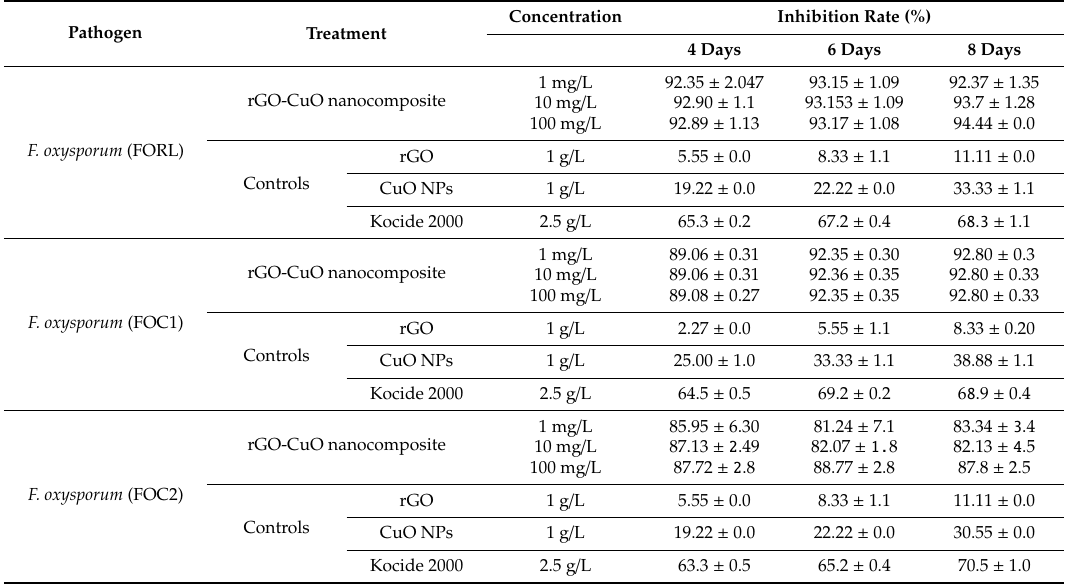
Table 1. Mean of inhibitory growth rate (%) of the pathogenic three F. oxysporum isolates with the smaller size (5 nm) of the rGO-CuO